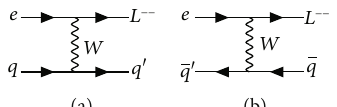
Figure 1: Decay width of doubly charged leptons for Λ = M 10 TeV, and Λ = 100 TeV.